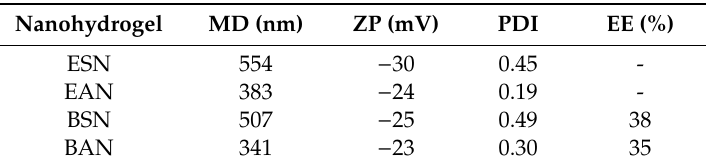
Table 7. Mean diameter (MD), zeta potential (ZP), polydispersity index (PDI) and entrapment e ffi ciency (EE %) of the